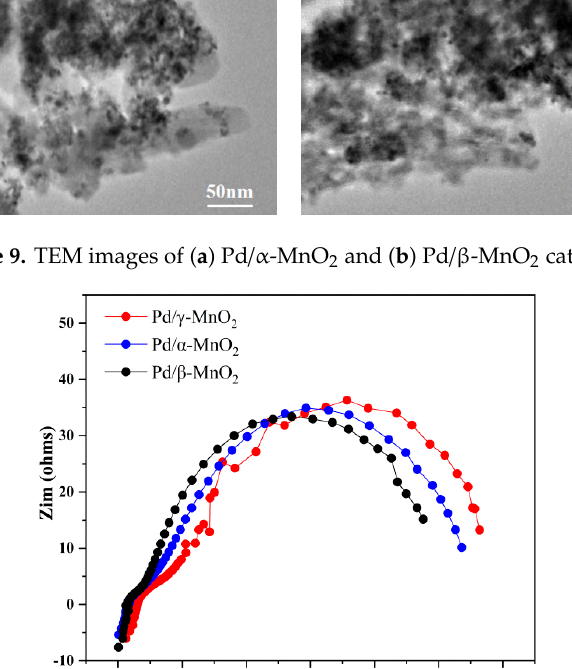
Figure 10. Electrochemical impedance spectra of Pd/ α -MnO 2 , Pd/ β -MnO 2 , and Pd/ γ -MnO 2 catalysts.